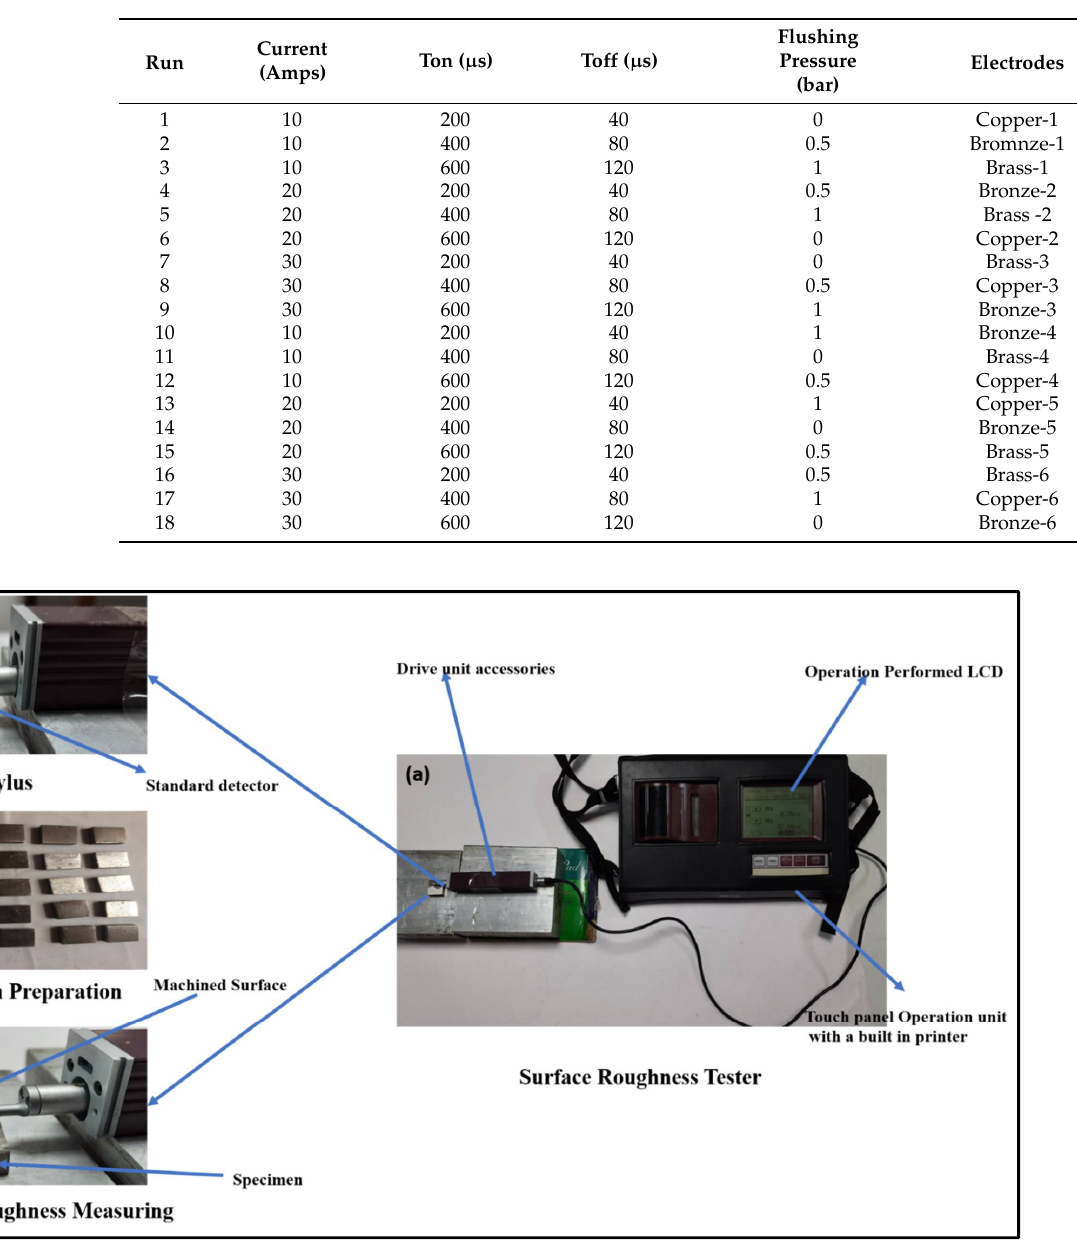
Table 2. Experimental layout using L 18 orthogonal array.